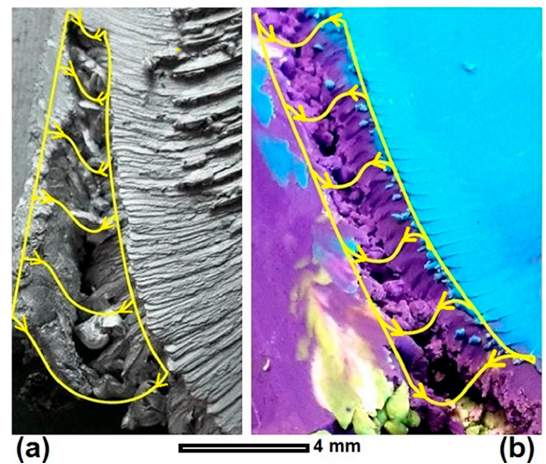
Figure 10. Schematic of the entry scour region for the channel discontinuity: ( a ) aluminium weld; and ( b ) analogue plasticine.